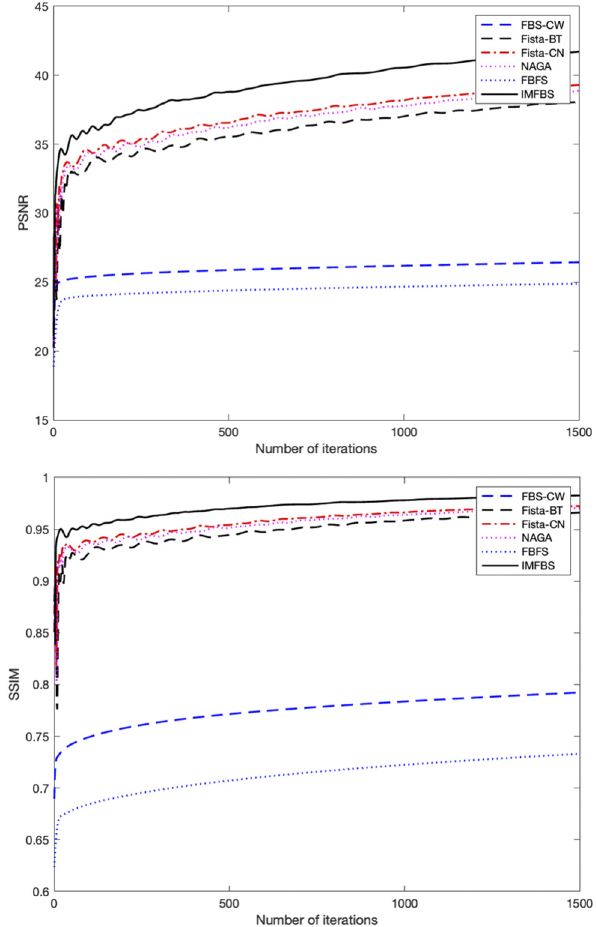
Figure 6: Graphs of PSNR and SSIM for FIG ( A ) by out of focusing,